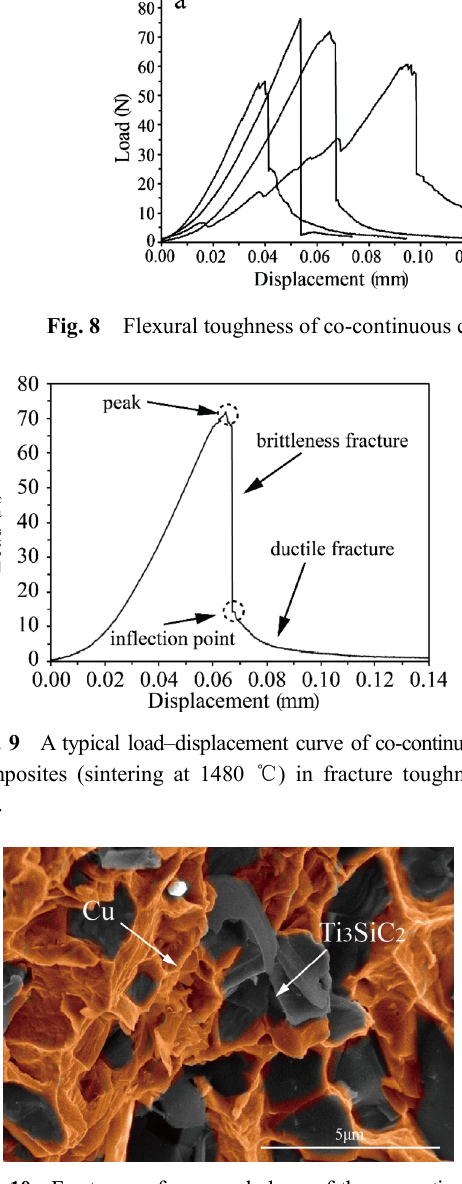
Fig. 10 Fracture surface morphology of the co-continuous